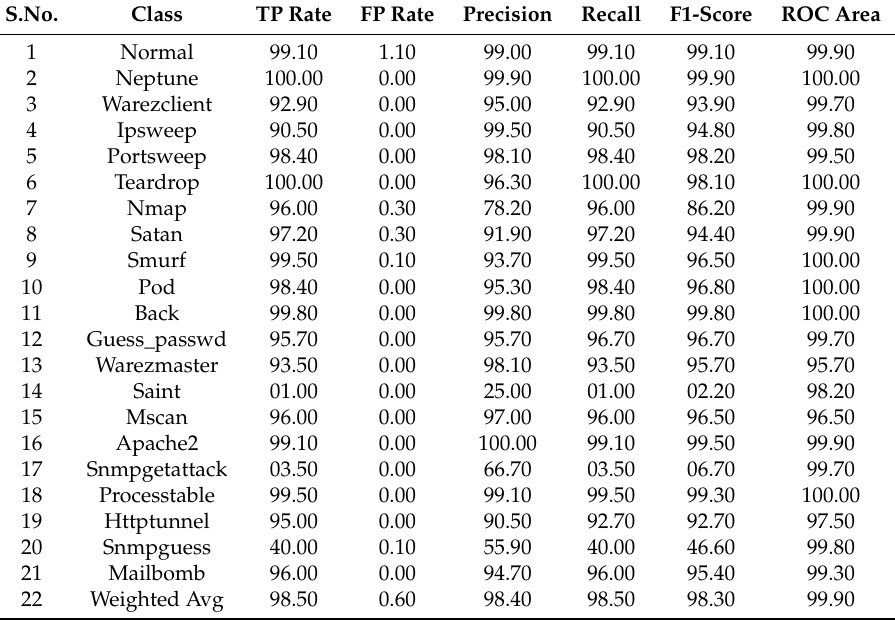
Figure 11. Classification report for the Adaboost Reptree NSLKDD dataset. Table 42. Multiclass classification report for NSLKDD using Bagging